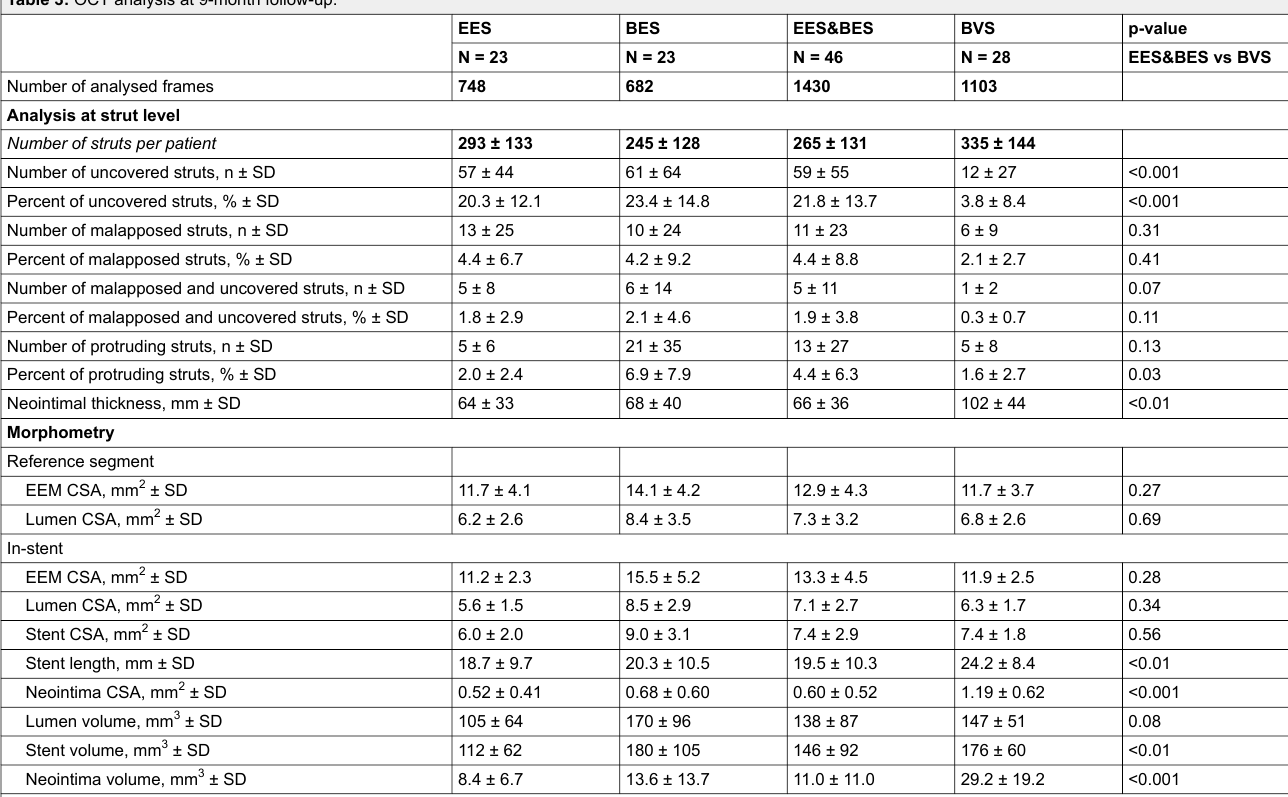
Table 3: OCT analysis at 9-month